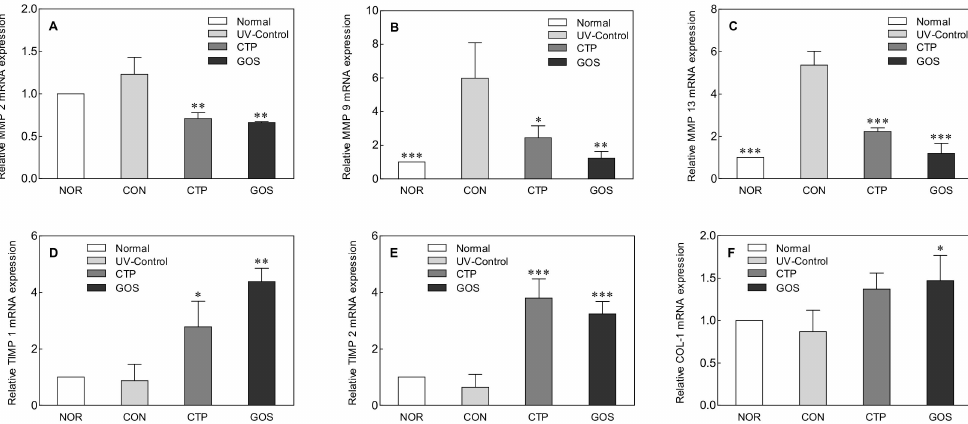
Figure 3. E ff ect of galacto-oligosaccharide (GOS) intake on matrix metalloproteinase (MMP) ( A – C ), tissue inhibitors of MMP (TIMP) ( D , E ), and collagen-1 (COL-1) ( F ) mRNA expression in ultraviolet (UV) B-irradiated hairless mice. Data are expressed as mean ± standard deviation, and di ff erent symbols indicate significant di ff erences at * p < 0.05, ** p < 0.01 and *** p < 0.001 vs. CON group. Normal (NOR; unirradiated mice); ultraviolet (UV) B control (CON; irradiated and untreated mice); CTP intake at 200 mg / kg (CTP; irradiated and CTP-treated mice); GOS intake at 200 mg / kg (GOS; irradiated and GOS-treated